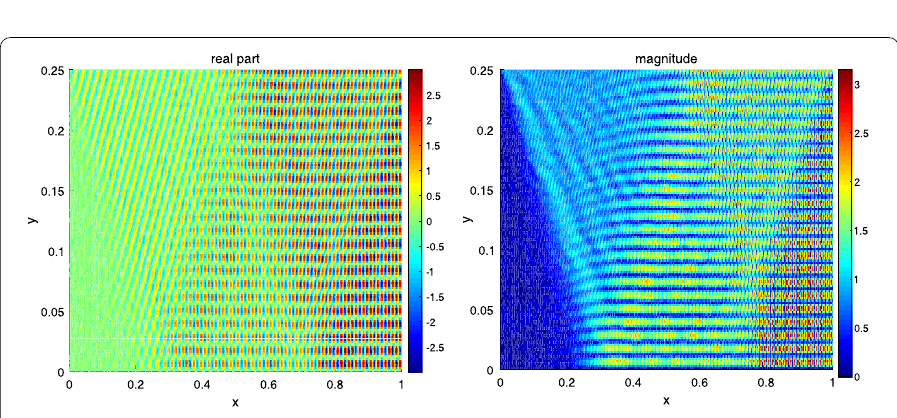
Figure 4 Real part (left) and magnitude (right) of the solution with k = 128 π , N =